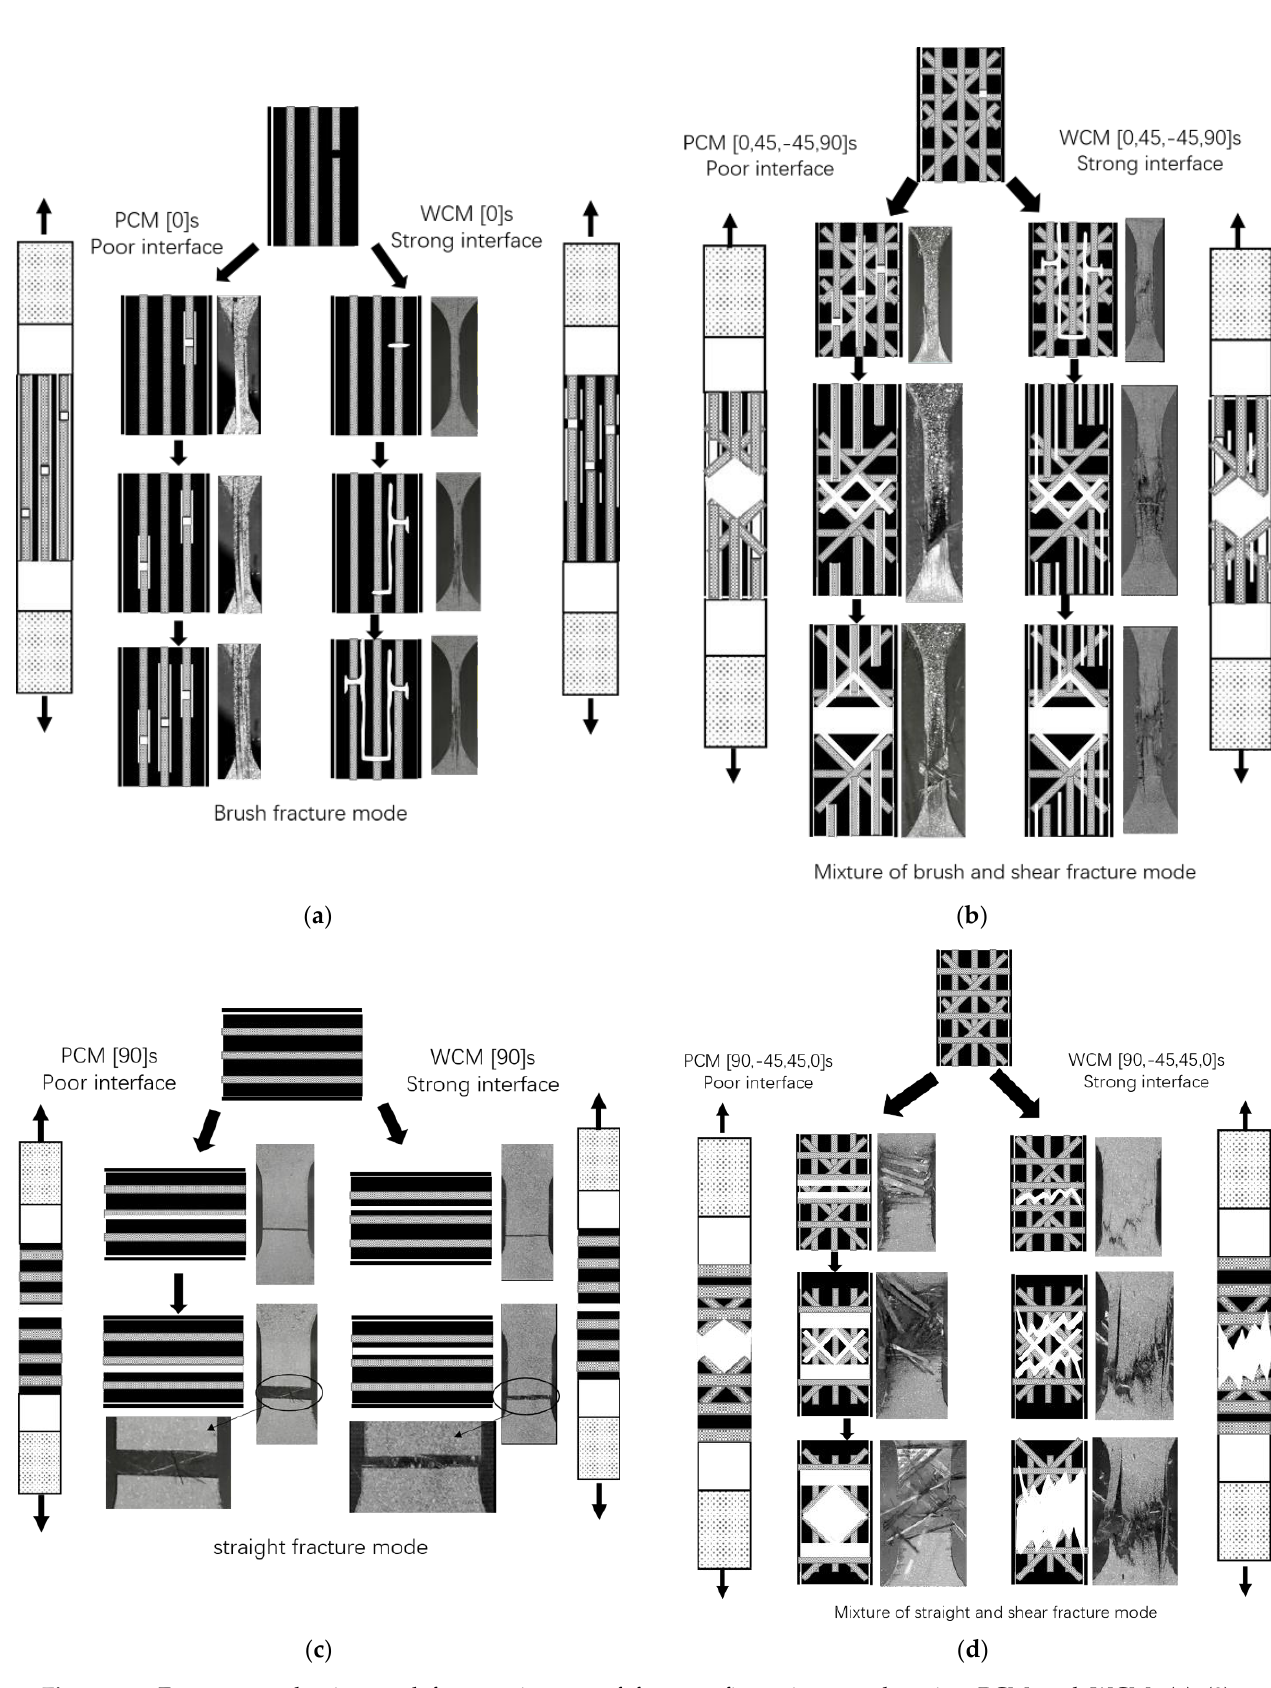
Figure 6. Fracture mechanism and fracture images of four configurations made using PCM and WCM: ( a ) (0)s; ( b ) [0/45/−45/90]s; ( c ) (90)s; ( d ) [90/−45/45/0]s.